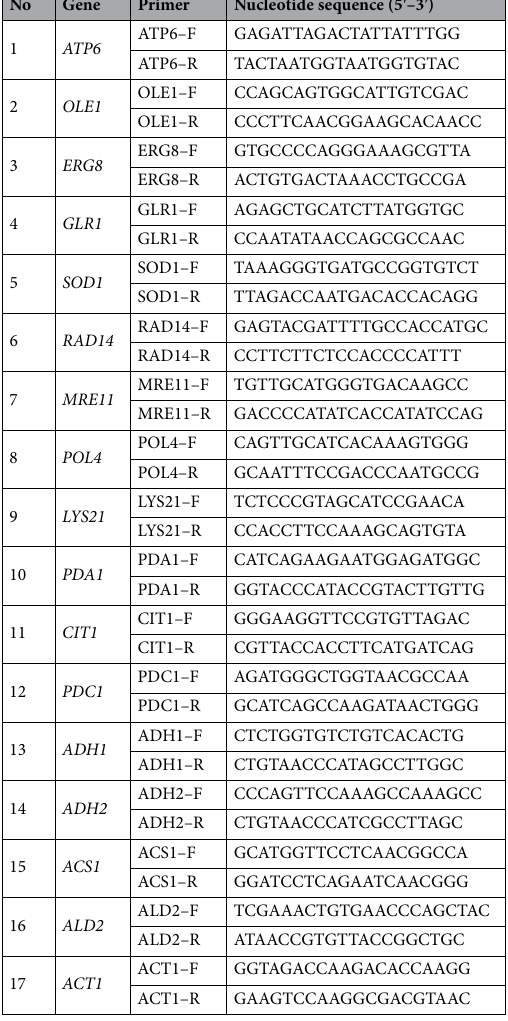
Table 2. A list of primer pairs used for